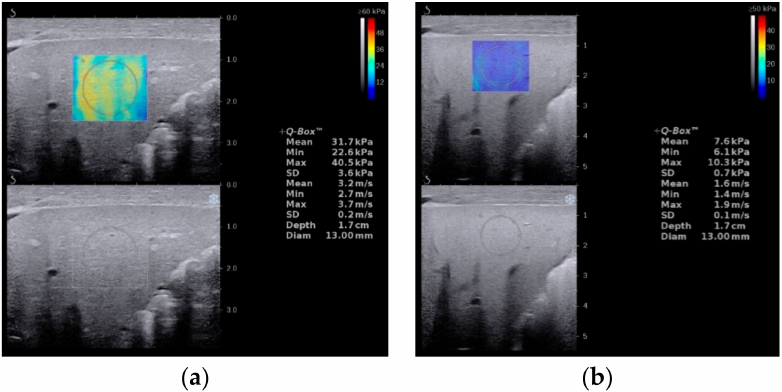
Figure 7. Liver stiffness measurement images of biliary atresia ( a ) and non-biliary atresia ( b